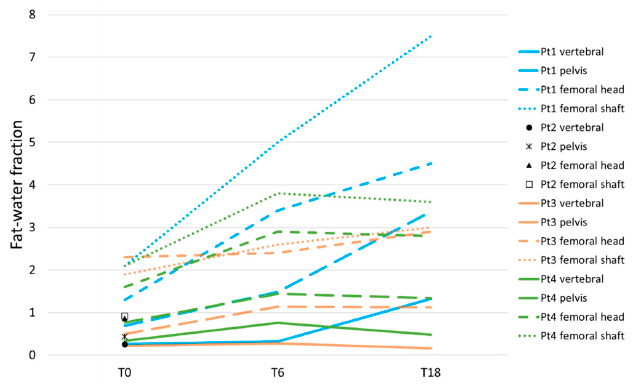
Figure 2. Fat–water fractions as measured by Dixon.